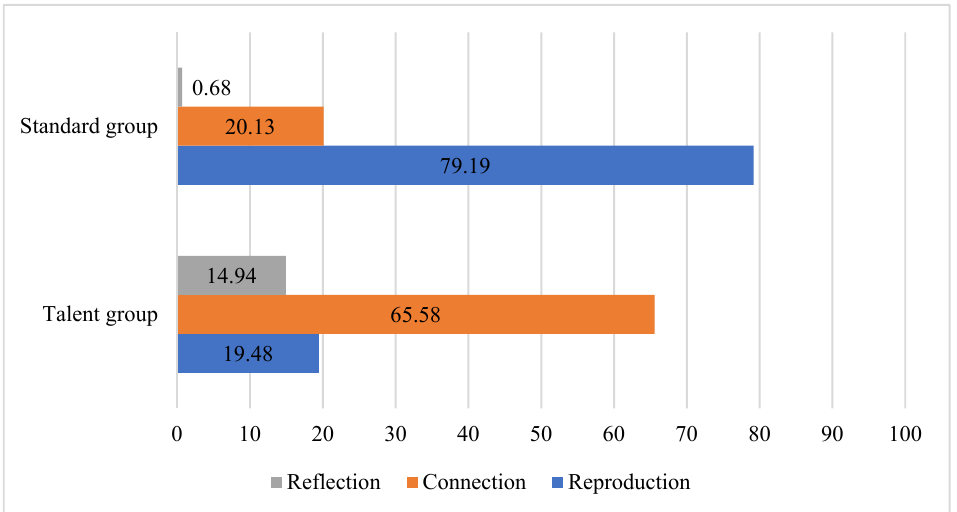
Figure 3. Complexity of the problem according PISA. Percentage by group.